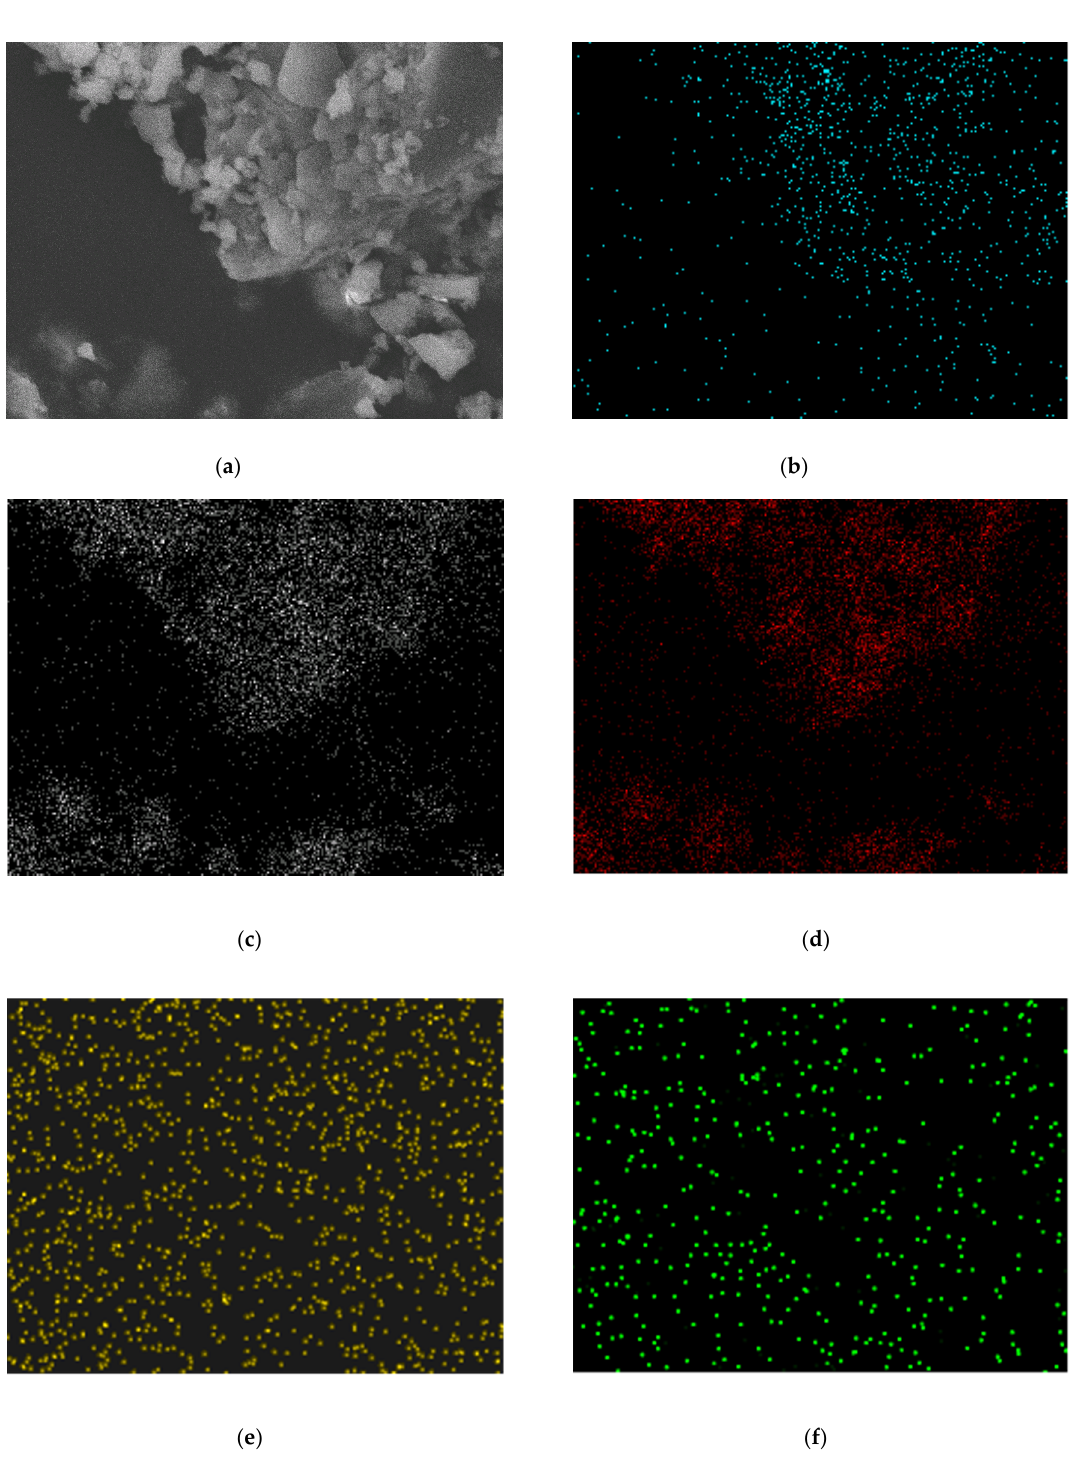
Figure 7. SEM mapping image of ( a ) 20%Pt-Ba 0.5 AlO x / C catalyst, ( b ) Ba, ( c ) Al, ( d ) O, ( e ) C, and ( f ) Pt element.